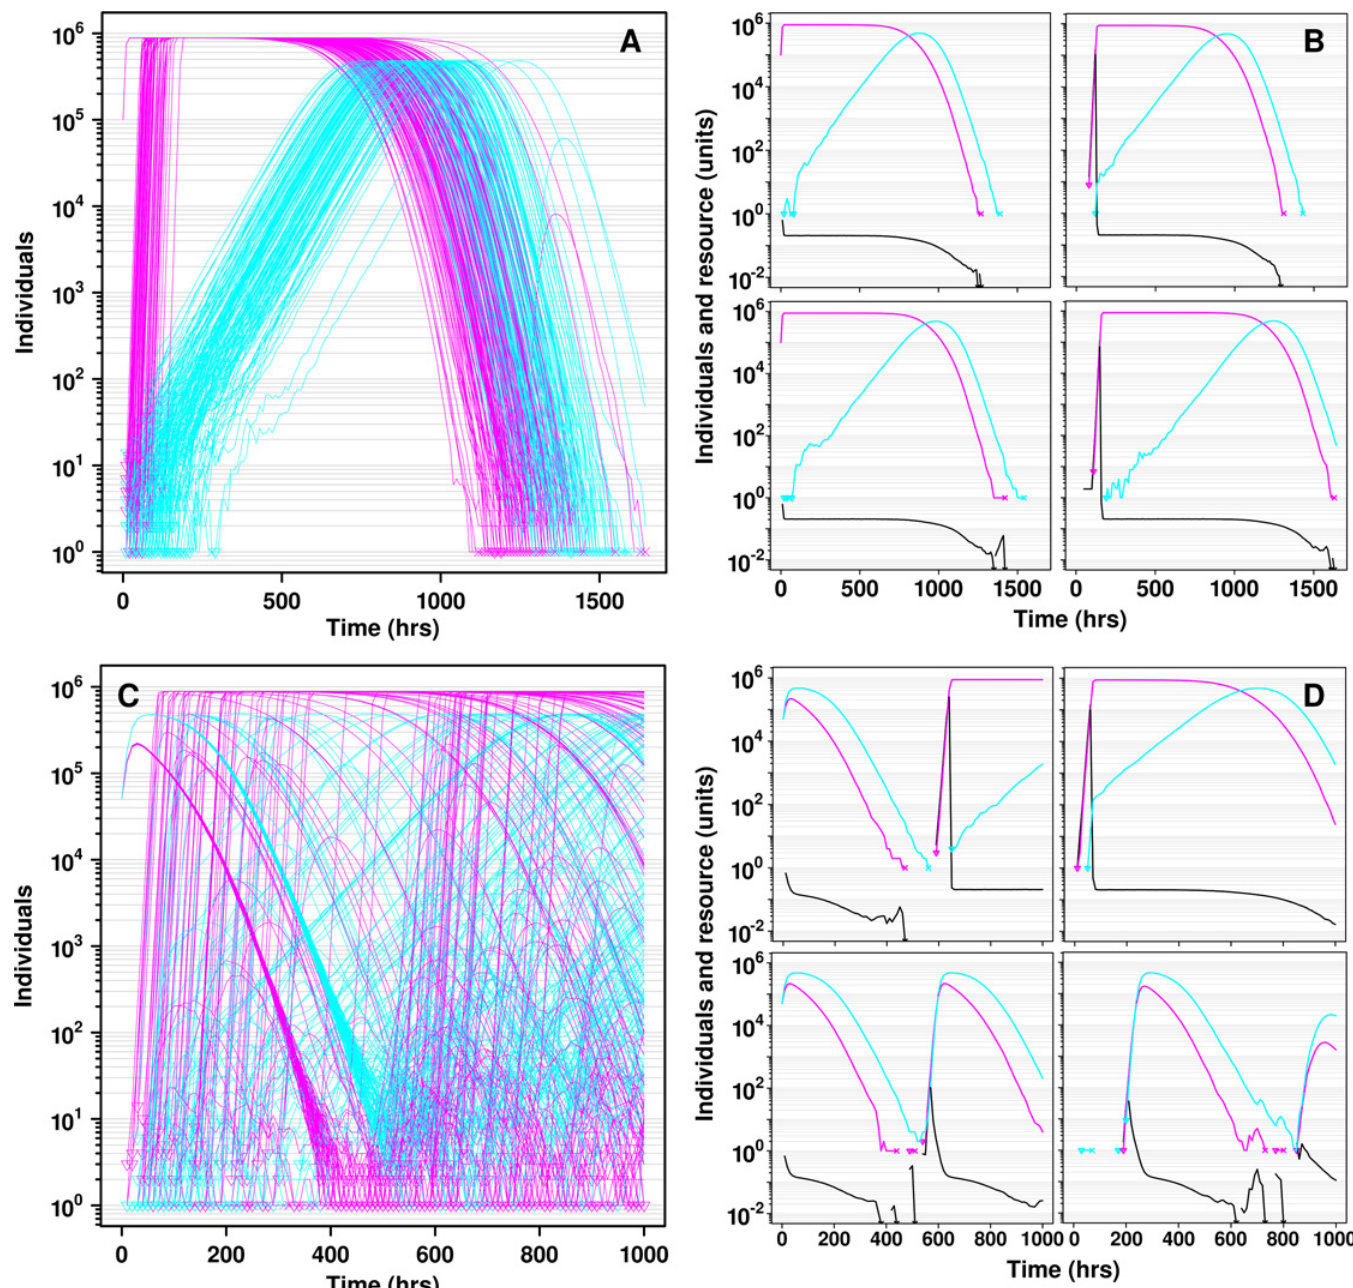
Fig 6. The initial presence of defectors can increase cooperator survival when empty locations are available. A-B ) 50% of locations were initially seeded with C * cells only and they mutated to D * at u D = 10 − 7 hr -1 . A ) All 144 locations on the same plot. B ) Four plots of individual locations (resource in black). After the first 200 hours, initially-occupied (left) and initially unoccupied (right) locations showed the same behavior: resident or migrant C * cells grew to high density, and mutation to D * became appreciable. In all locations, although D * appeared at somewhat different times (mainly through mutation, since migration was insignificant at small population size), D * populations all slowly grew and caused local population collapse Consequently, most metapopulations went extinct. C-D ) 50% of locations were initially seeded with C * and D * cells at 1:1. C ) All 144 locations on the same plot. D ) Four plots of individual locations (resource in black). While the initially-occupied locations crashed at about the same time (left), initially unoccupied locations showed different dynamics depending on whether C * or D * migrated into these locations (right). Thus, heterogeneity in dynamics promoted the survival of cooperation in these metapopulations because locations vacated by early population extinctions could be colonized by surviving C * from